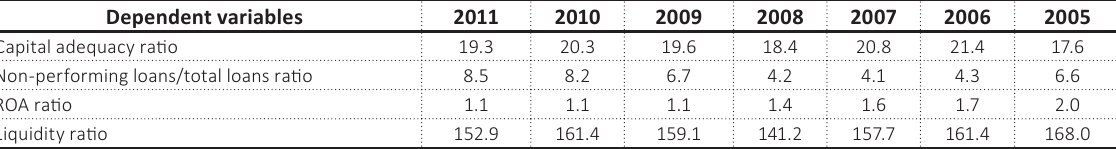
Table 2. Dependent variables (in %) for six years (2005–2011)